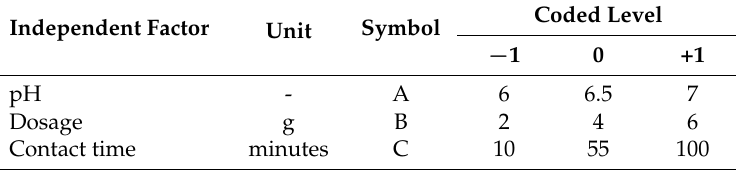
Table 1. Summary of the experimental design for colour adsorption by the pretreated